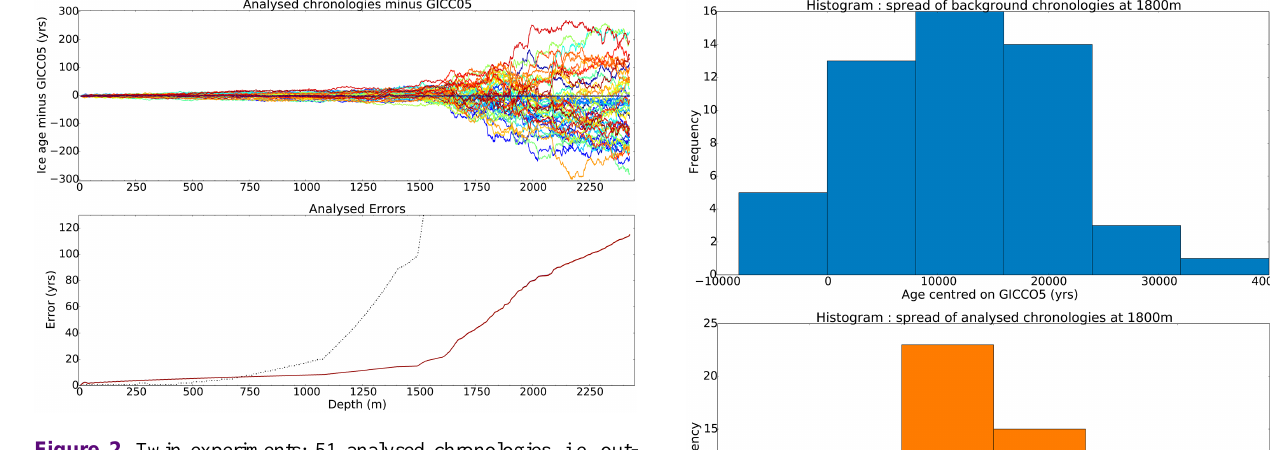
Figure 2. Twin experiments: 51 analysed chronologies, i.e. out- put chronologies from Datice. Top: comparison of the 51 analysed chronologies with GICC05. Bottom: the corresponding 51 analysed errors (red). The dashed black line represents the maximum count- ing error associated with GICC05 and considered as equivalent to a 2 σ uncertainty.